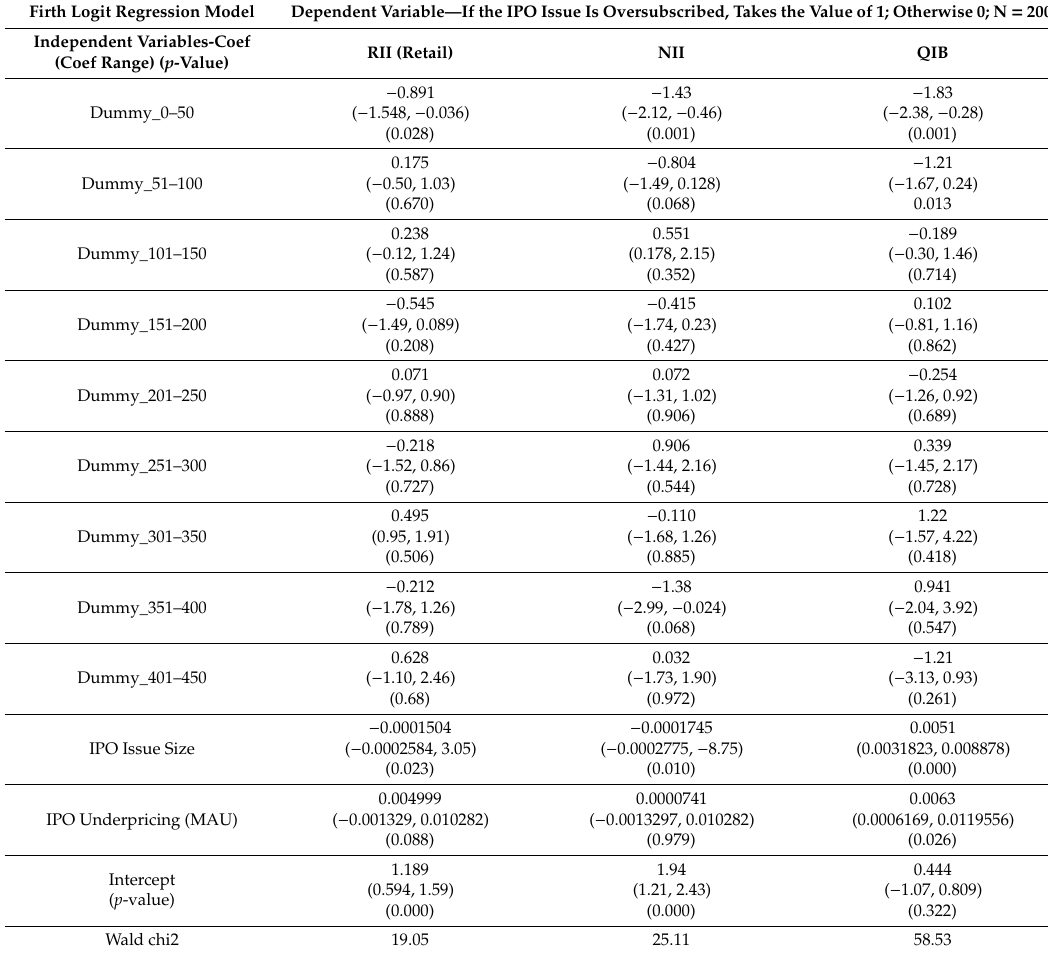
Table A1. Results of the firth logistic regression model. The e ff ect of IPO o ff er price range and issue-specific characteristics on the oversubscription or undersubscription of an IPO listing among investors